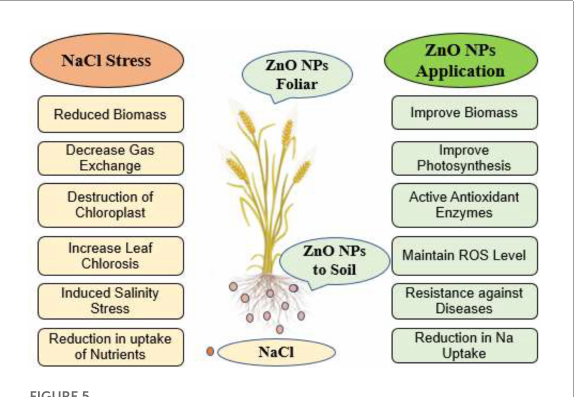
FIGURE5 Graphical representation of the effects of exogenously applied ZnO NPs and salinity stress on the plant growth and physio-biochemical attributes of